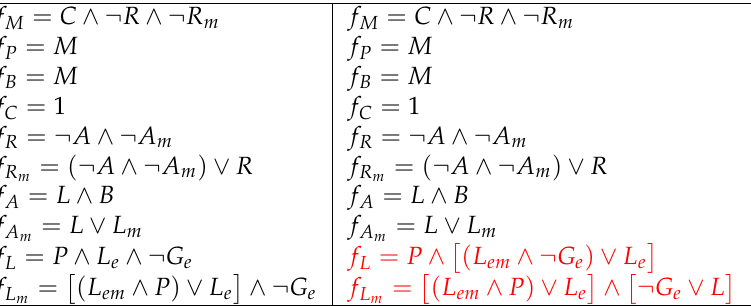
Figure 9. The original model ( left ) and the improved original model ( right ), where changes are marked in red.